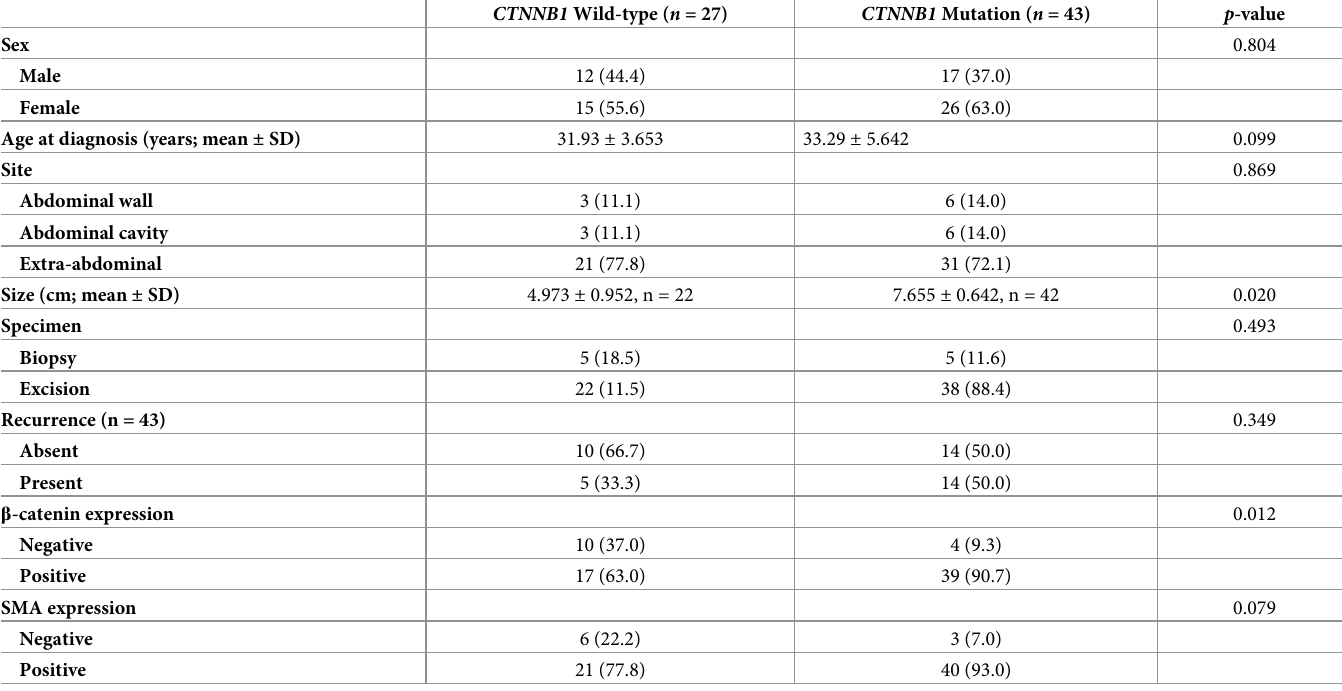
Table 2. Clinicopathological findings in desmoid-type fibromatosis patients according to CTNNB1 mutation status.